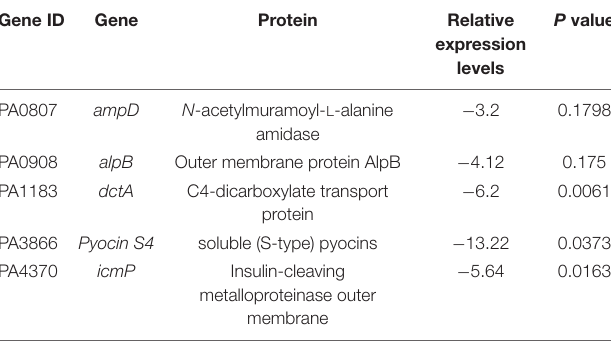
TABLE 1 | Quantitative real time PCR experiments to quantify the effect of AHCC§on the transcript levels of genes which are related to bacterial pathogenicity in P. aeruginosa infected IEC18